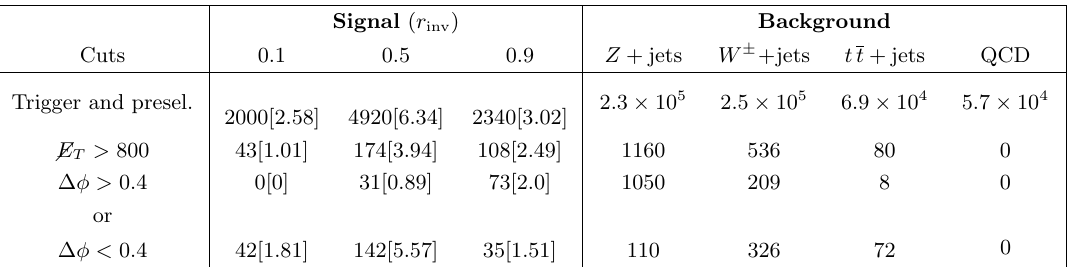
Table 1 . Cut-(cid:13)ow table for the vector contact operator, assuming a production cross section (cid:27) ( p p (cid:31) (cid:31) ) = 1 pb for = 37 fb (cid:0) 1 at 13 TeV. We show the number of signal and background ! L events that remain after trigger/preselection cuts, as well as after the addition of a missing energy cut with either (cid:1) (cid:30) > 0 : 4 or < 0 : 4. The numbers in brackets correspond to an estimate of the signi(cid:12)cance s= p s + b at each stage of the cut-(cid:13)ow, where s ( b ) is the number of signal(background) events. The (cid:30) E T cuts are optimized in each signal region; we only show the results for (cid:30) E T > 800 GeV here as an example. Figure 7 highlights the complementarity between the two di(cid:11)erent search strategies in covering the full range of r inv . The left panel shows the bounds on the e(cid:11)ective contact operator scale, (cid:3), while the right panel shows the bounds on the production cross section (cid:27) ( p p (cid:31) (cid:31) ), as a function of r inv . Solid lines show the results for a standard !